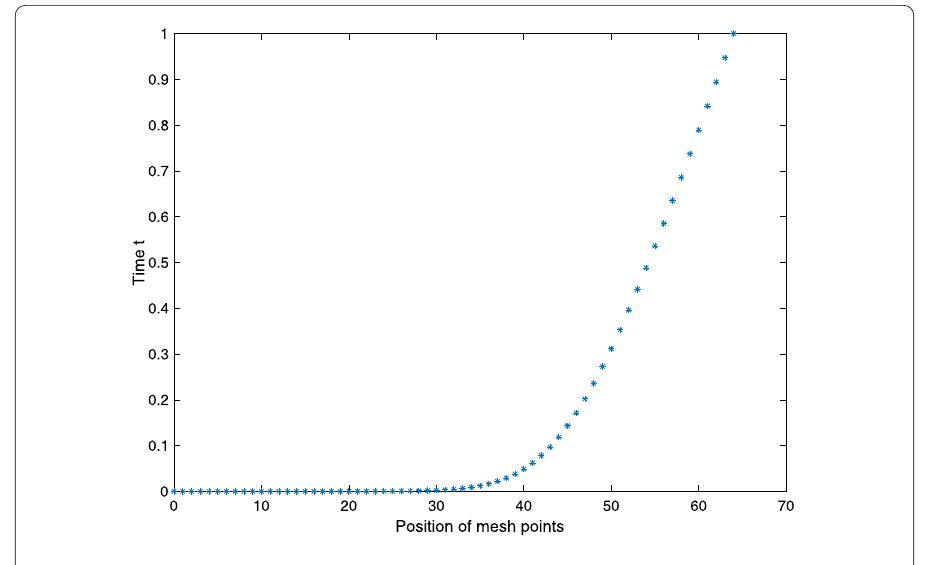
Figure 4 Final computed time mesh for Example 5.2 with α = 0.2